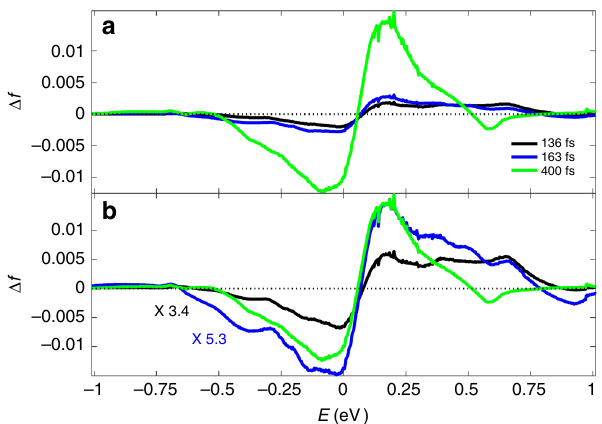
Fig. 6 Changes in carrier population for the Kretschmann con fi guration. a Spectrum cuts of Δ f ( E ), inferred from the second integral Eq. (4), at t = 136, 163, 400 fs. The relatively broad initial electron energy distribution change at the earlier time (136 fs) evolves to a narrower and larger magnitude Fermi – Dirac distribution at later time (400 fs). b Same as a but with multiplication factors in order to better compare the various time functional